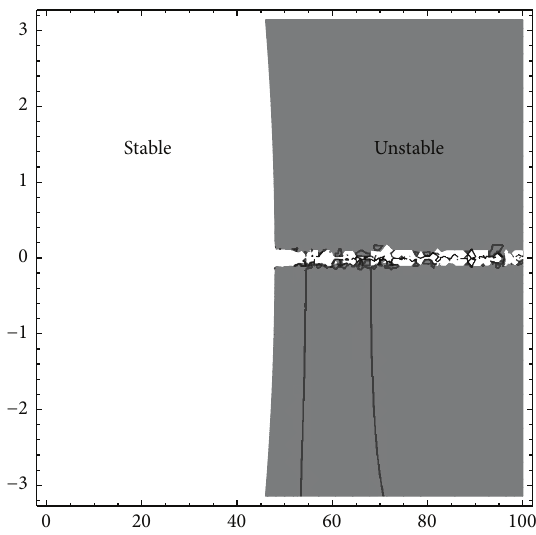
Figure 1: The stability region plotted in the ( 𝑞,𝑢